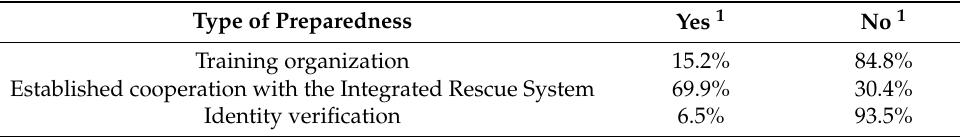
Table 7. Additional focus to increase security at